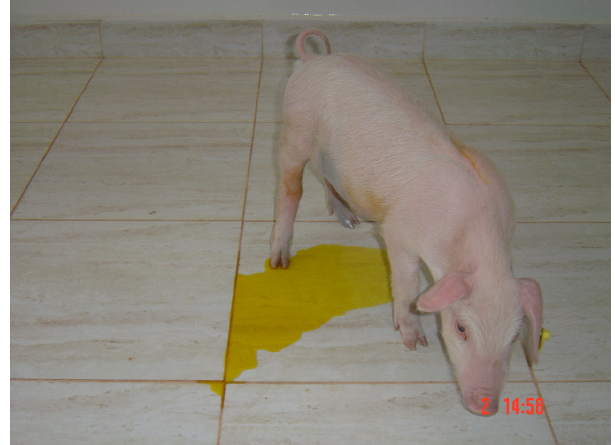
FIGURE 3 - Swine subjected to experimental biliary obstruction by ligation of the common bile duct, where there is jaundiced skin and intensely yellow color of